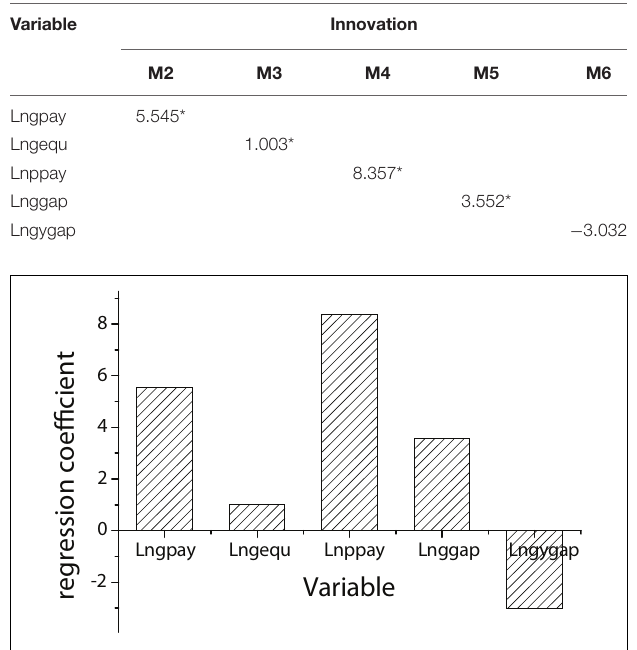
is 8.357, showing a positive correlation at the level of 1%. It indicates that ordinary employee salary has a positive effect on enterprise innovation efficiency, which validates H2. The regression coefficient between the internal salary gap of the senior management team and the enterprise innovation efficiency is 3.552, which is significantly positively correlated at the level of 1%. It indicates that the internal salary gap of the senior management team has a positive effect on enterprise innovation efficiency, which validates H3. The regression coefficient of the with the innovation performance of the enterprise is − 3.032, which is significantly negatively correlated at the level of